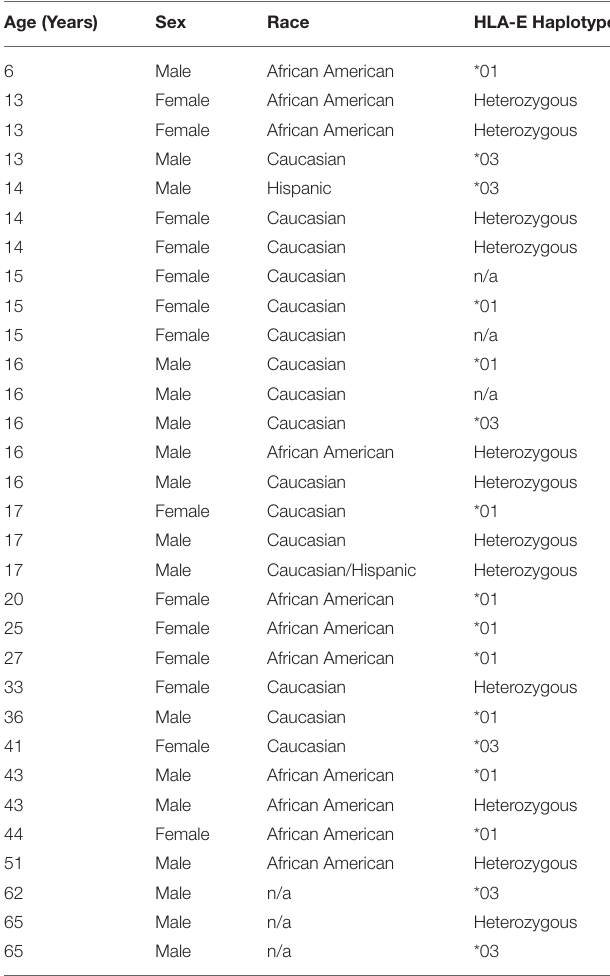
TABLE 1 | Participant Ty21a vaccinees listed by age (years), sex, race, and HLA-E